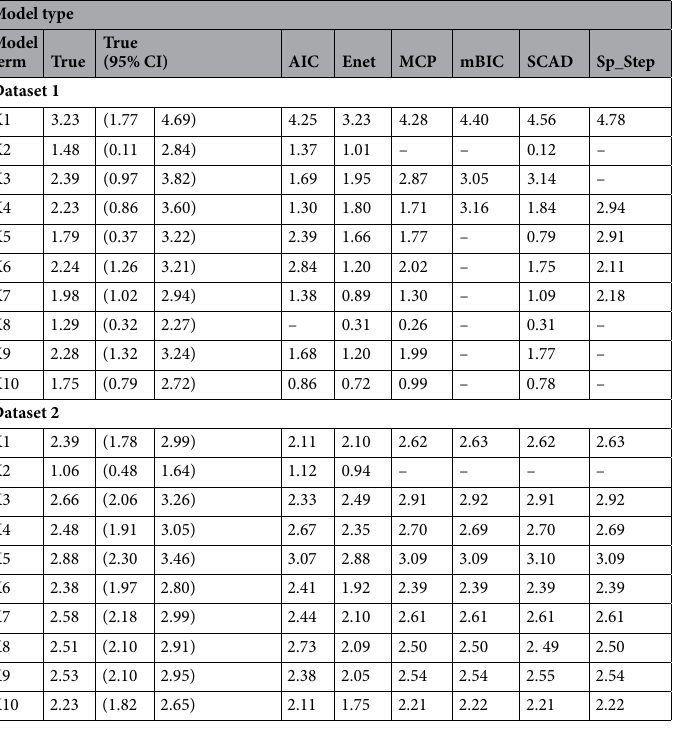
Table 2. Comparison of coefficient estimates for ten ‘true’ variables specified in the underlying model for Datasets 1 and 2 for six statistical methods of variable selection. Both datasets contained 1000 observations and 910 potential explanatory covariates. True the correct partial coefficient distribution, AIC Stepwise selection based on Akaike Information Criterion, Enet elastic net regression, MCP minimax convex penalty, mBIC modified Bayesian Information Criterion, SCAD smoothly clipped absolute deviation, Sp_Step SparseStep